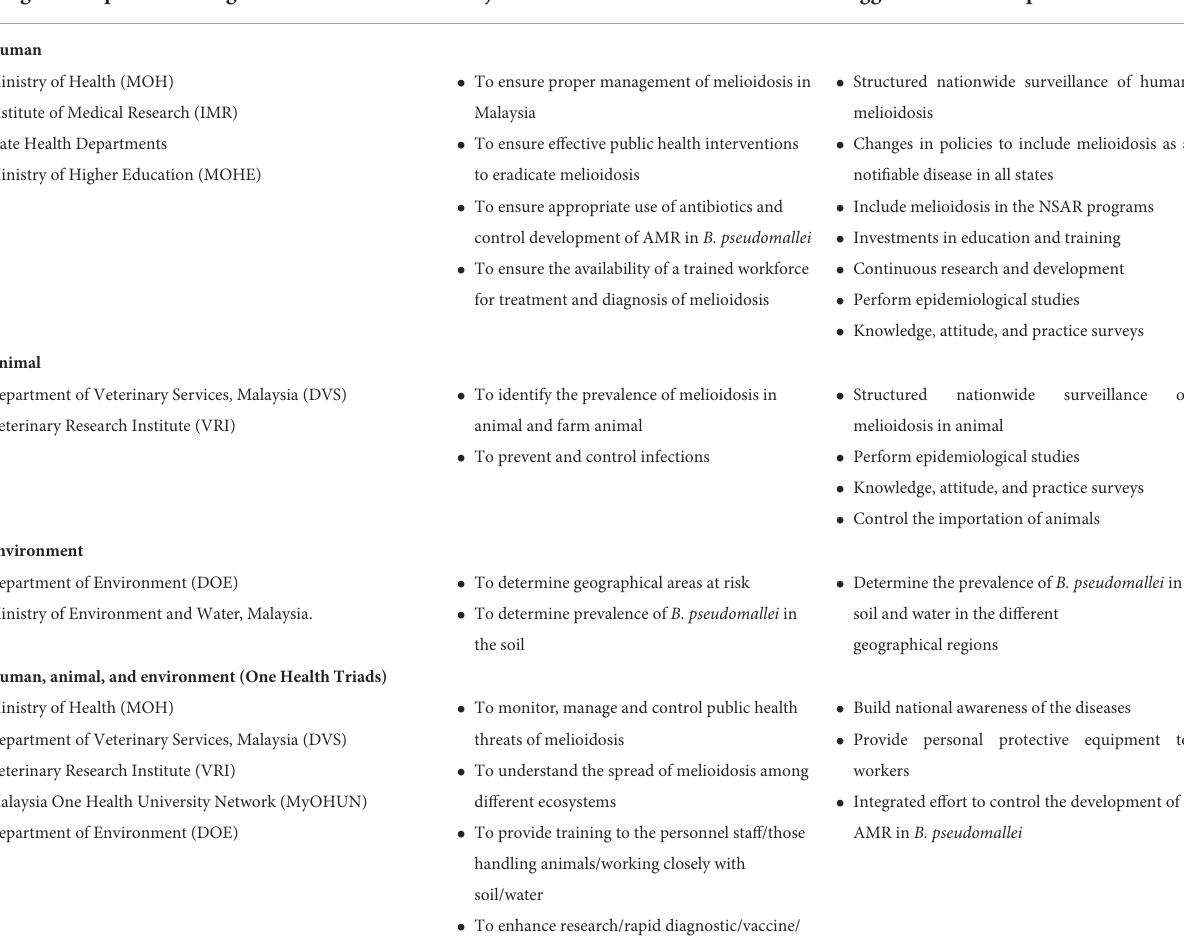
TABLE 2 Proposed One Health implementation activities on melioidosis and glanders